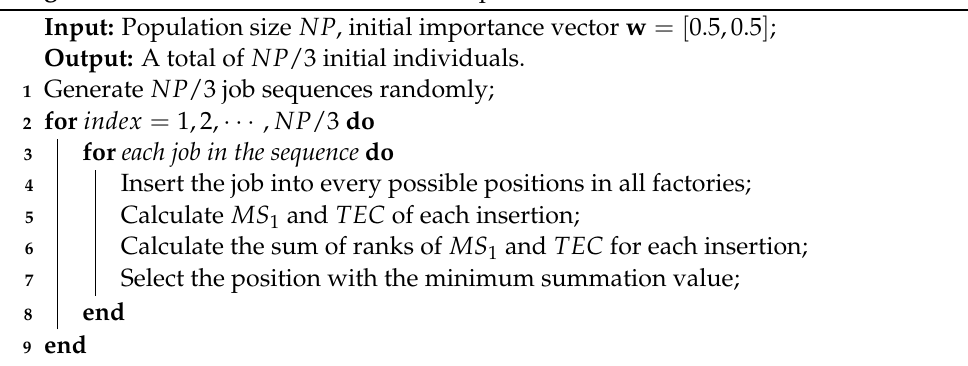
Algorithm 2: NEH heuristic with biased